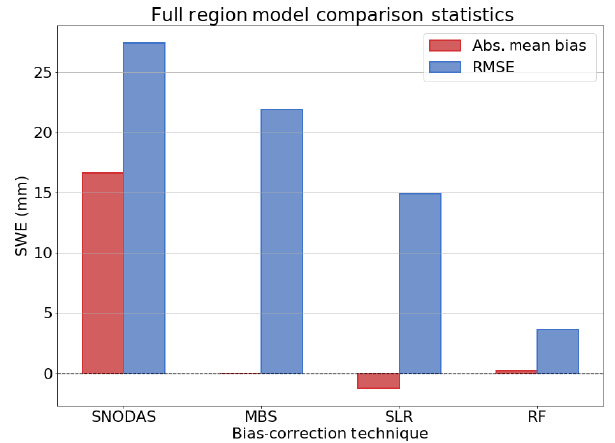
Figure 3. Bias-correction model performance results for each tech- nique across the full spatio-temporal